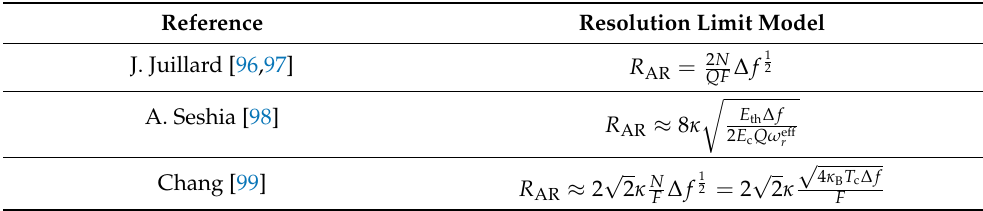
Table 5. Comparison of resolution limit model of 2-DoF WCRs.